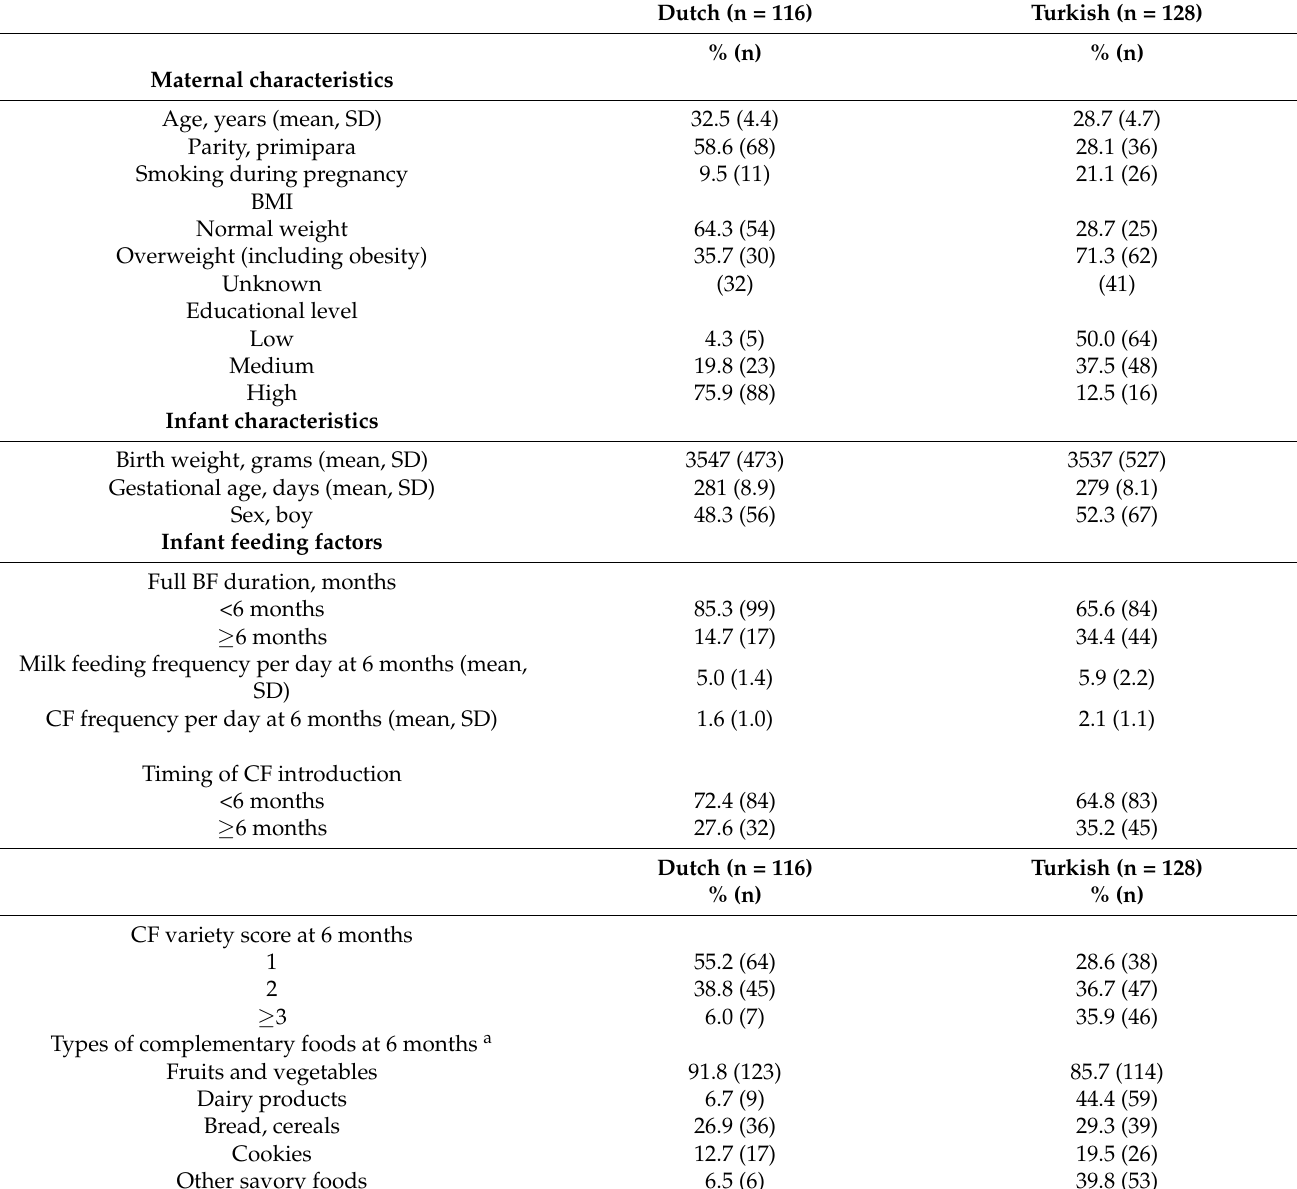
Table 1. Characteristics of study population by ethnicity (n = 244). All values are % (n) unless otherwise